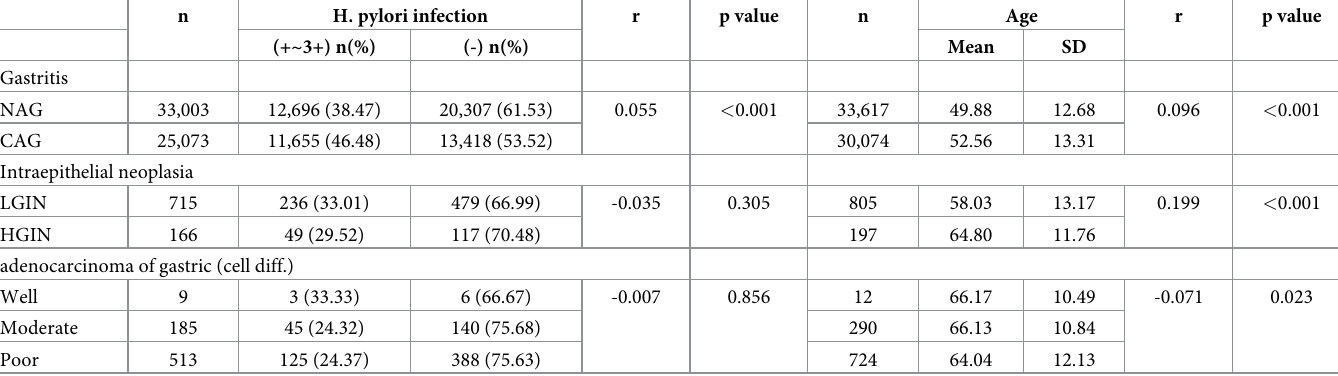
Table 3. Infection with helicobacter pylori and age in relation to the histological type of gastric diseases. n H. pylori infection